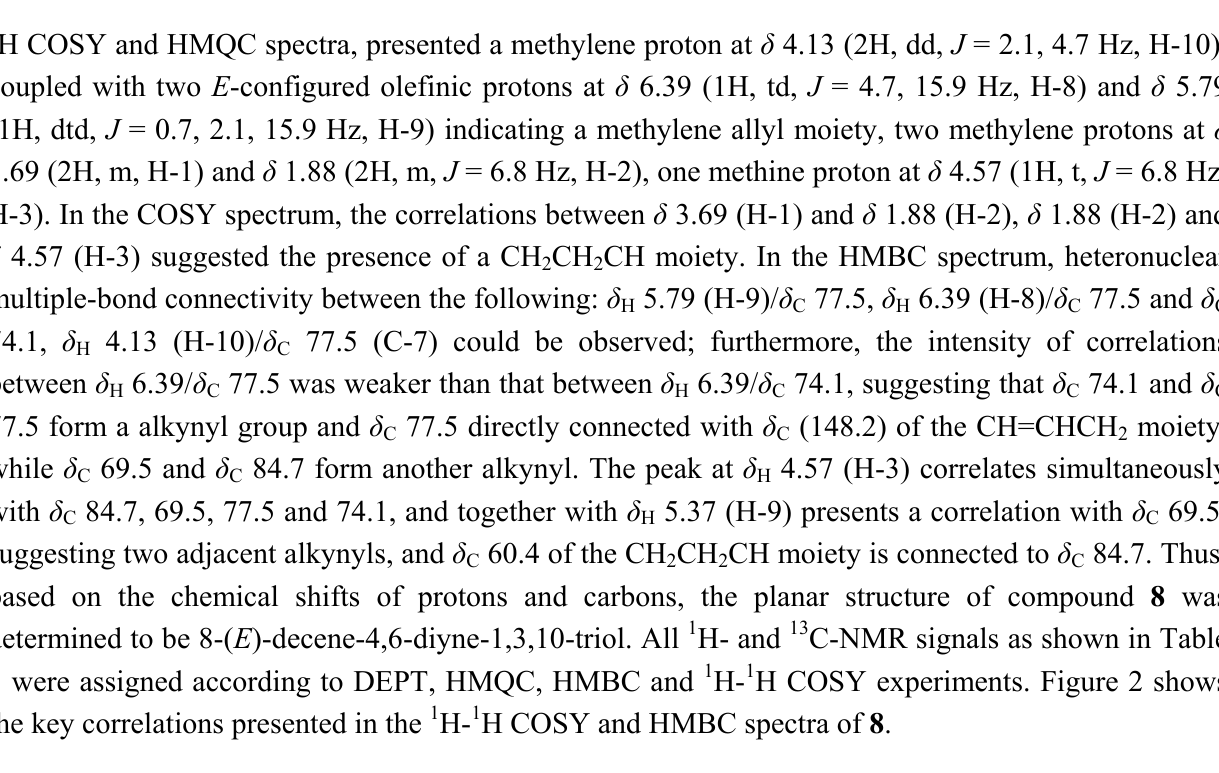
Table 1. 13 C-NMR (100 MHz, in CD